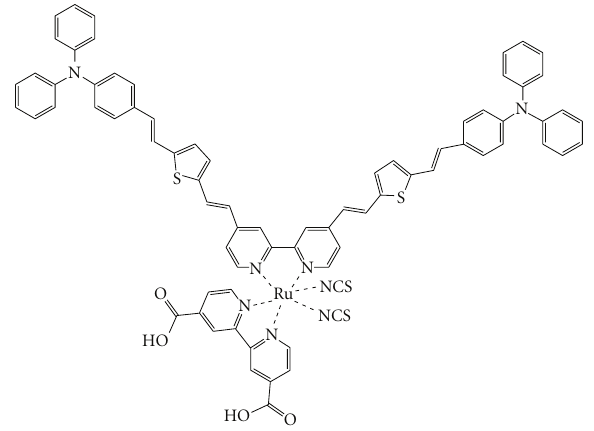
Figure 1: Molecular structure of E322